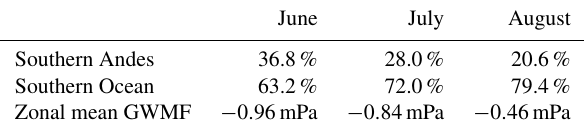
Table 2. Percentage of total zonal momentum flux at z = 40km in the latitude band 68 to 35 ◦ S for June–August 2010. Negative flux values indicate a westward direction. The southern Andes re- gion (which includes the Drake Passage and the tip of the Antarctic Peninsula) is defined here as between longitudes of 80 and 55 ◦ W, while the Southern Ocean region is defined as all longitudes outside of this, as shown by orange and grey dashed lines in Fig. 9c. In terms of surface area, the southern Andes and Southern Ocean regions as defined here cover approximately 7% and 93%, respectively, of the total surface area in the latitude band 68 to 35 ◦